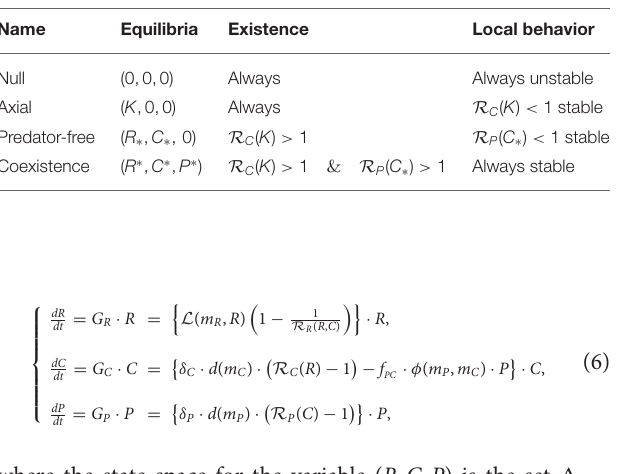
TABLE 2 | Steady states, existence and positive conditions for the system (Equation 6) with type I functional